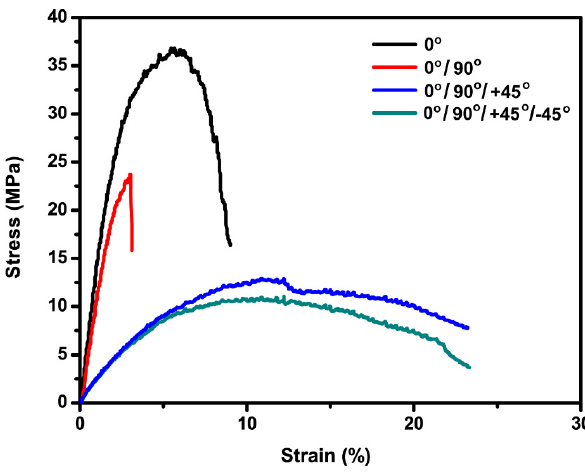
Figure 9: Tensile stress-strain curves with different fiber